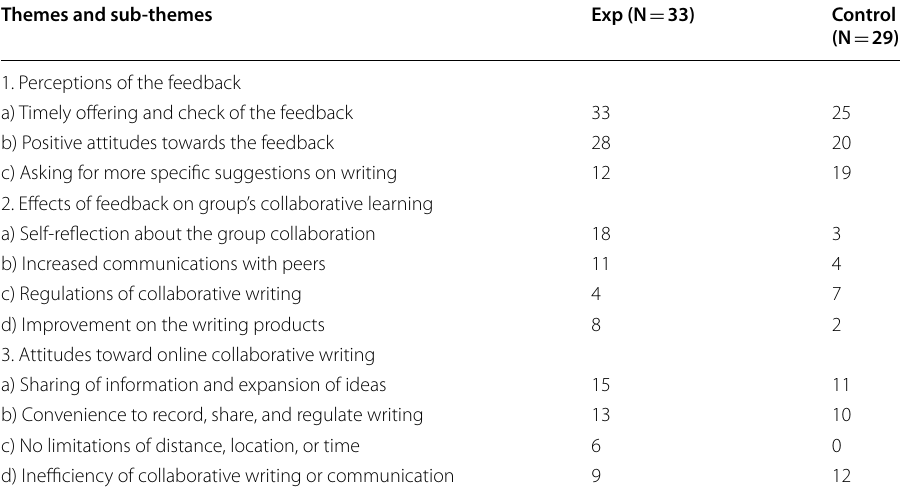
Table 7 Themes and sub-themes extracted from student reflections under two conditions Themes and